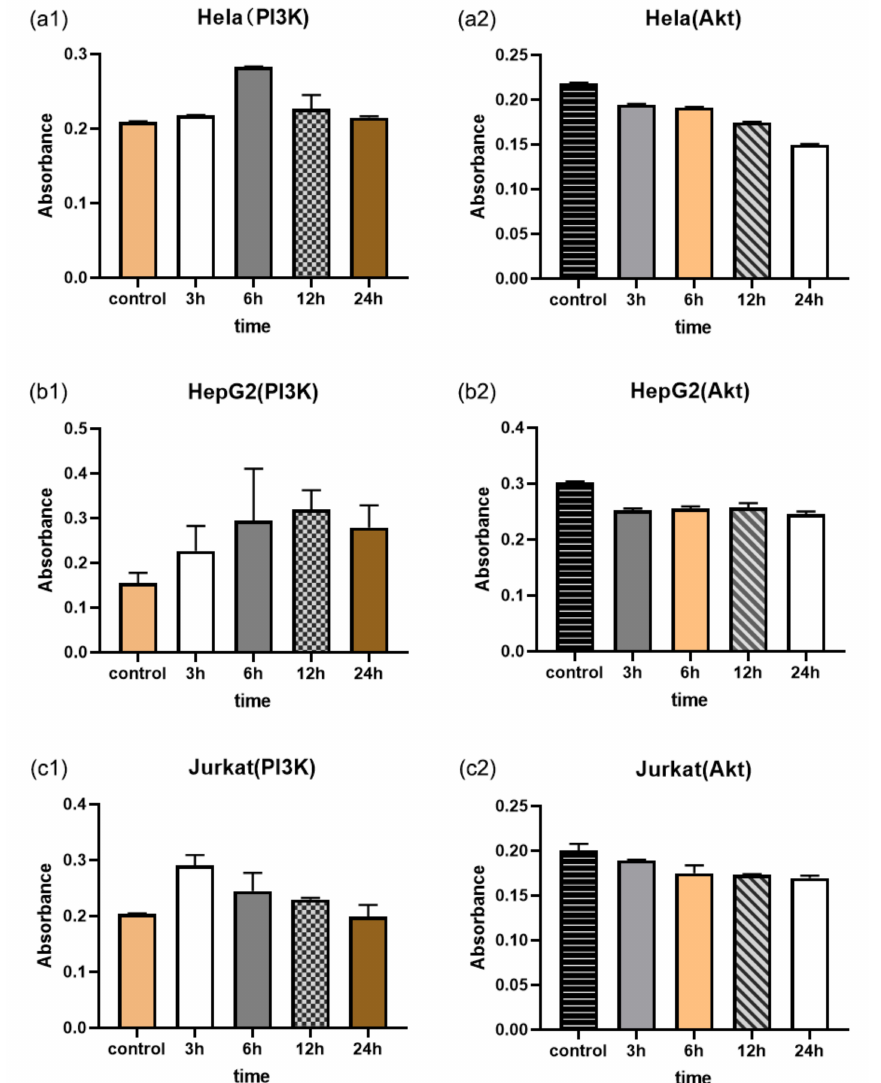
Figure 5. PI3K and Akt contents in the three Rg3-treated cell types, as ascertained by the absorbance measurements obtained using the PI3K and Akt kits; ( a1 – c1 ) PI3K measurements; ( a2 – c2 ) Akt